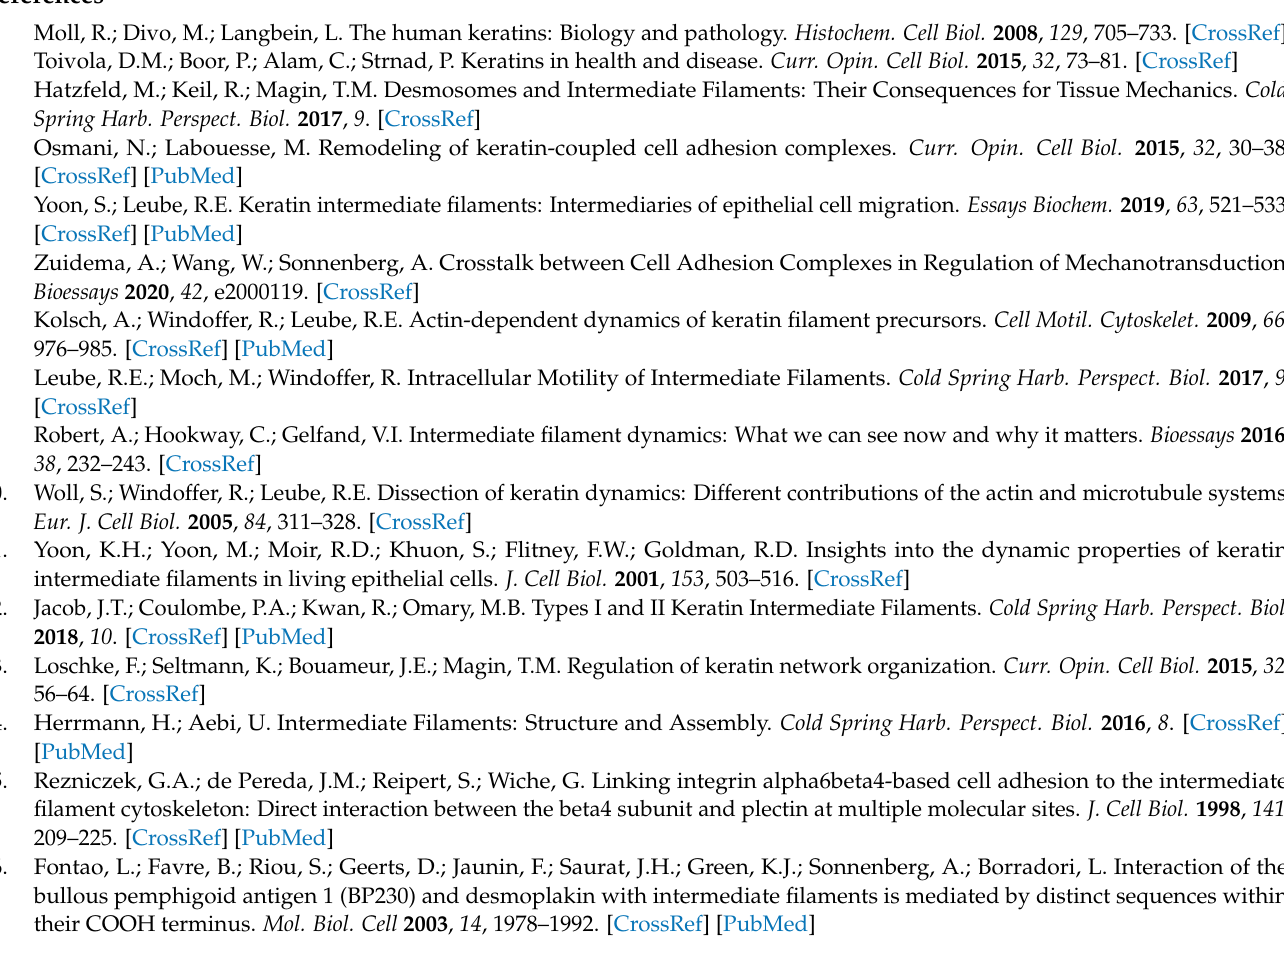
Figure 1C Figure 1E Figure A1 Mouse anti- β